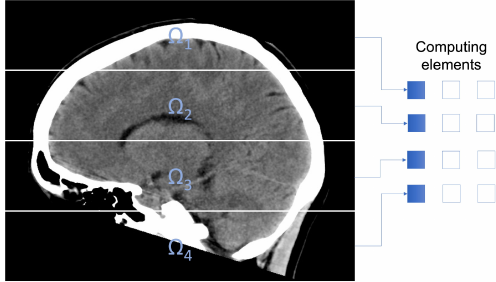
Figure 1 exemplifies the subdomains utilized in the experimentation.